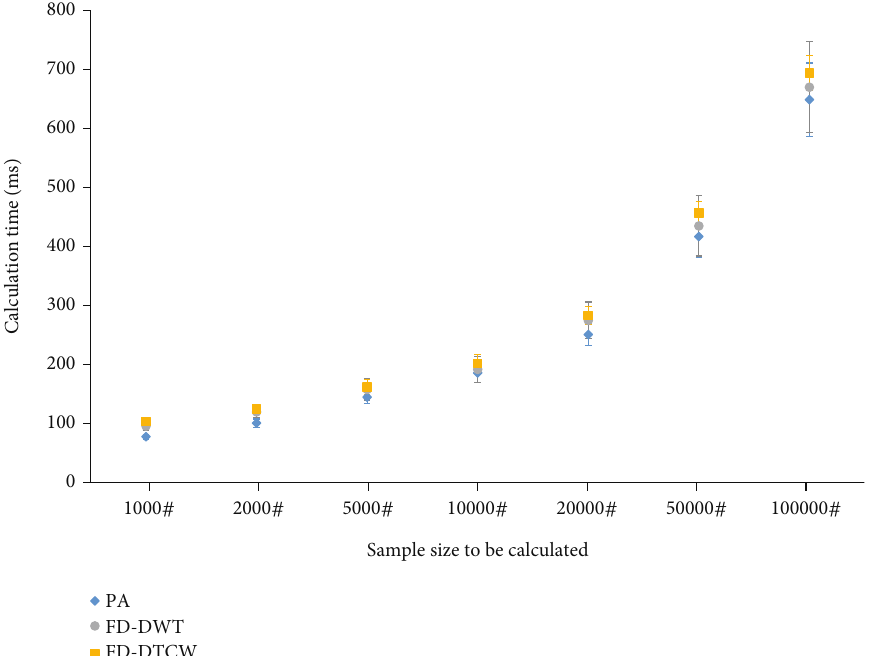
Figure 12: Time consumption of model calculation under di ff erent number of samples to be processed (unit: